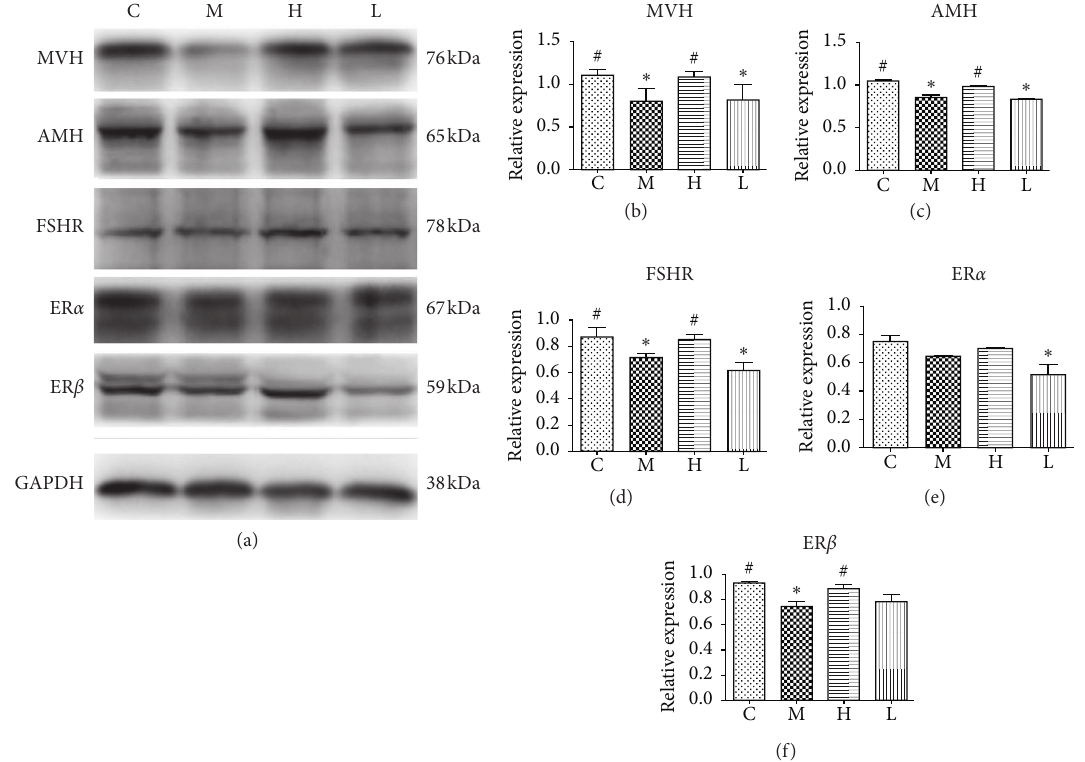
Figure 5: Western blot analysis of ovarian reserve function-related protein (MVH, AMH, and FSHR) and ER subtypes (ER α and ER β ) in ovarian follicles of each group. ∗ : significant compared to group (C) ( P < 0 . 05 ) ; #: significant compared to the group (M) ( P < 0 . 05 )